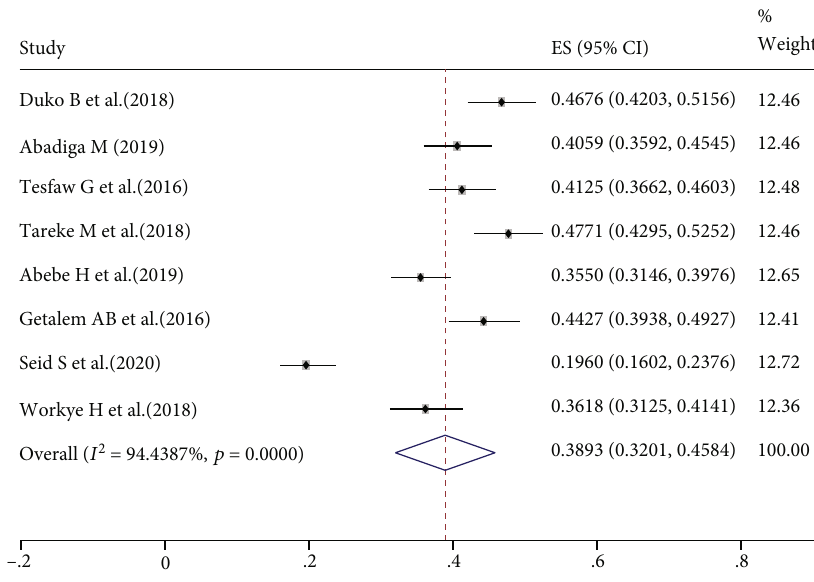
Figure 2: The pooled estimated prevalence of depression among HIV/AIDS patients in Ethiopia, 2020.